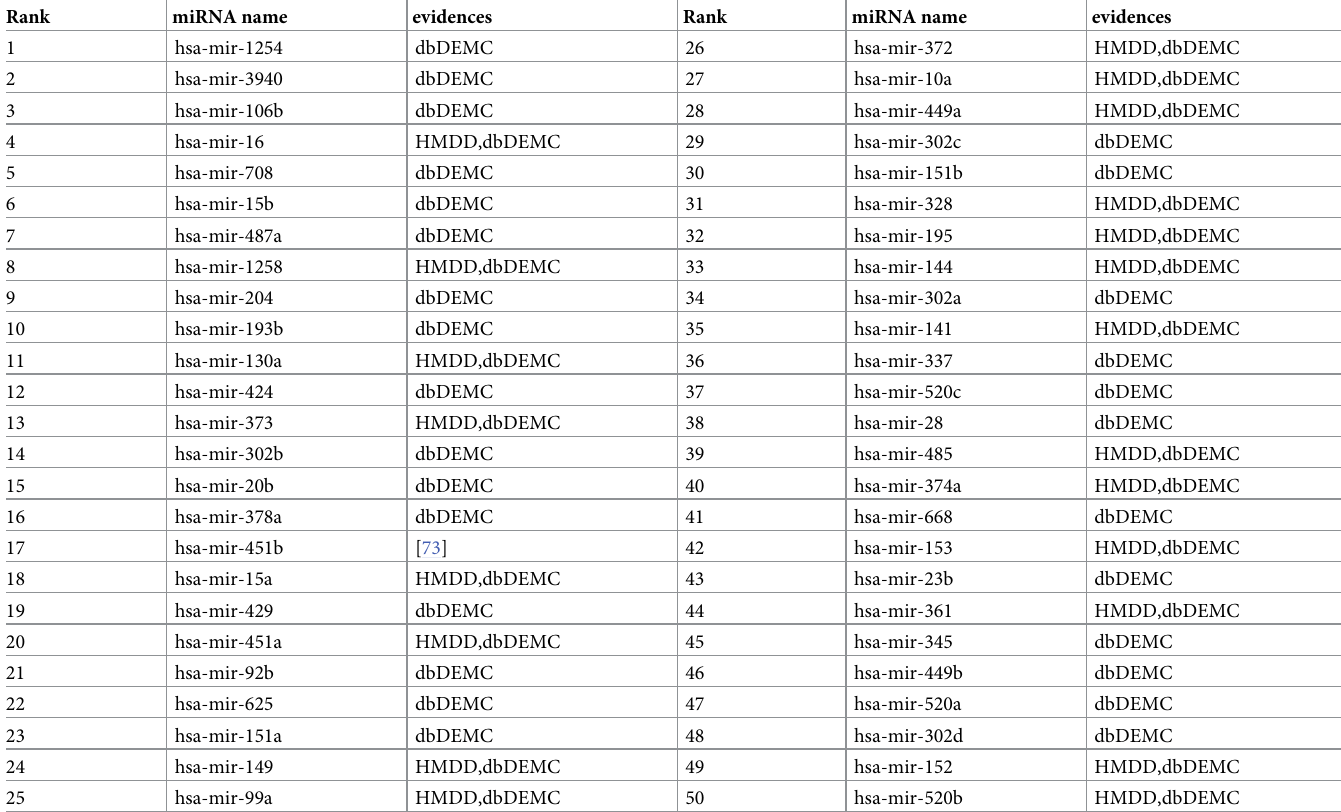
Table 1. The top 50 lung neoplasm–related